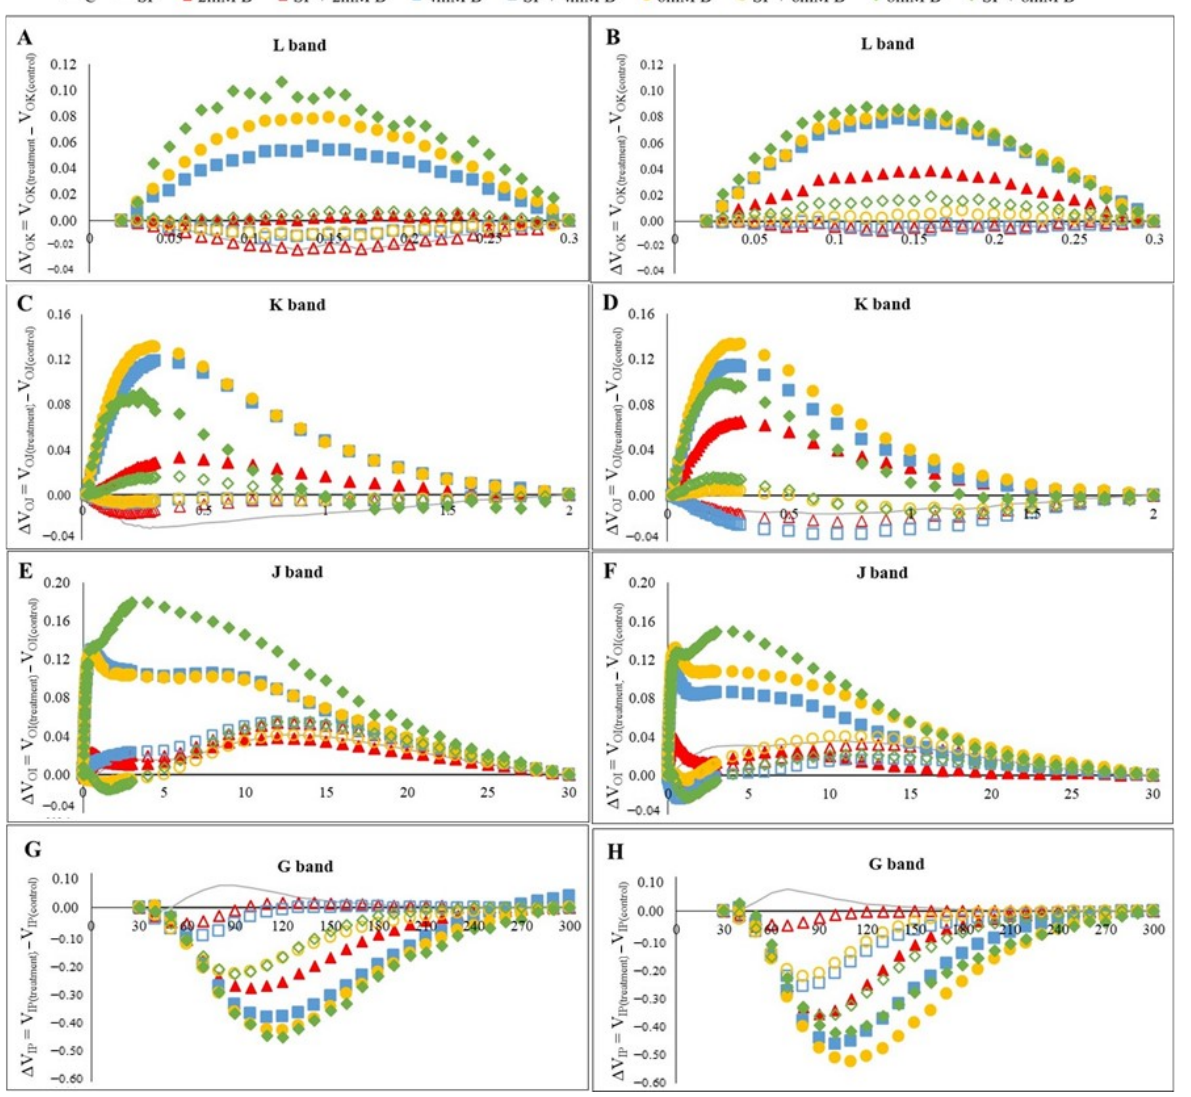
Figure 4. Differences in fluorescence rise kinetics double normalization between O and K (L band), [normalization to relative fluorescence values between 20 and 300 µs, Δ V OK = V OK(treatment) − V OK(control) ]; O and J (K band), [normalization to relative fluorescence values between 20 µs and 2 ms, Δ V OJ = V OJ(treatment) − V OJ(control) ]; O and I (J band), [normalization to relative fluorescence values between 20 µs and 30 ms, Δ V OI = V OI(treatment) − V OI(control) ]; I and P (G band), [normalization to relative fluorescence values between 30 ms and at the peak P of OJIP, Δ V IP = V IP(treatment) − V IP(control) ] of safflower cultivars submitted to toxic B with or without SP ( A , C , E , G , Dinçer; B , D , F , H , Remzibey-05, respectively). All these fluorescence transients are constructed from the corresponding values of the curves shown in Figure 3A,B. The mean values are plotted, n = 6.